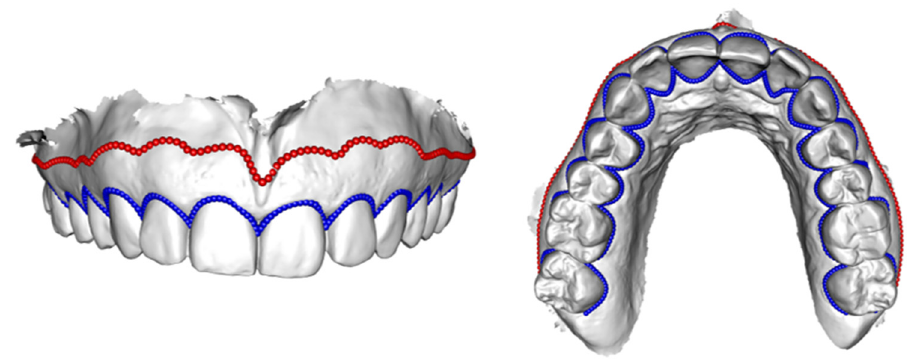
Figure 2. Detailed depiction of the sliding semi-landmarks set along the MT-BL (blue) and MG-BL (red). To achieve a proper representation of the MT-BL the tip of each interdental papilla was annotated with one additional landmark from each side (oral and buccal).